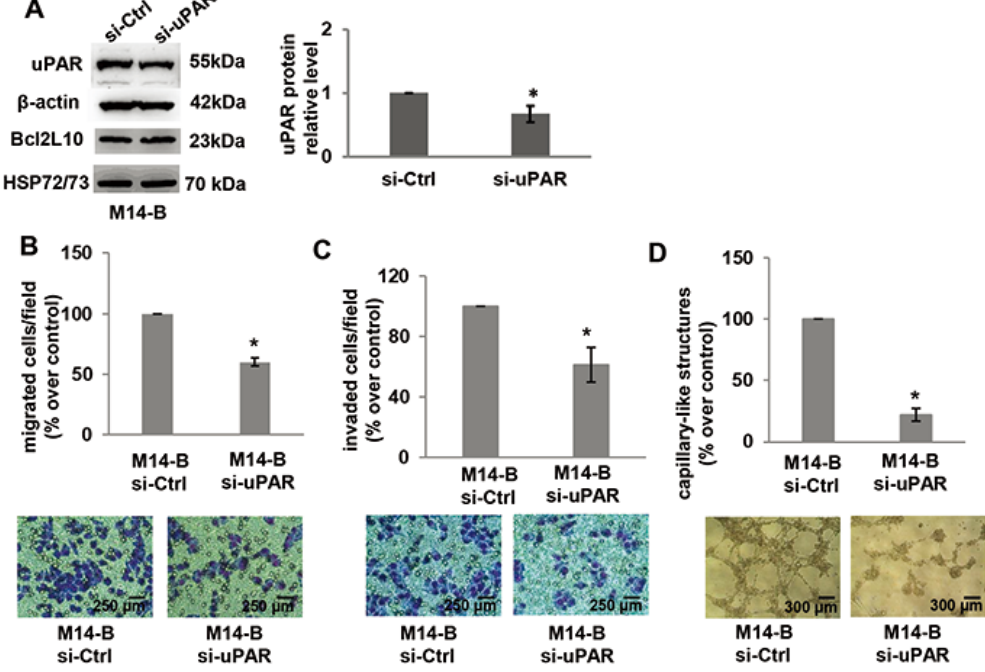
Figure 6. Bcl2L10 promotes migration, invasion, and VM of melanoma cells through uPAR. (A) Western blot analysis of uPAR and Bcl2L10 and densitometric analysis of uPAR protein expression in Bcl2L10 overexpressing M14 clone (M14-B) transfected with siRNA oligonucleotides against uPAR (si-uPAR) or scramble (si-Ctrl) target sequences. Reported images are representative of three independent experiments with similar results. β-actin and HSP72/73 were employed to check equal loading and transfer. For densitometric analysis, protein levels were quantified by using ImageJ software and the relative levels of proteins were expressed in the histograms as ratio changes respect to relative control after normalization. Data were expressed as mean ± standard deviation. Statistical analysis was performed applying corrected t test. (B–D) Quantification and representative images of in vitro cell (B) migration, (C) invasion, and (D) capillary-like structure formation in M14-B cells transfected with siRNA oligonucleotides against uPAR (si-uPAR) or scramble (si-Ctrl) target sequences. Values are expressed as a percentage of migrated/invaded cells or capillary-like structure formed respect to control. (B–D) Each condition was analyzed in duplicate in three (C) or two (B, D) independent experiments. Data were expressed as mean ± standard deviation. Scale bars have been reported. Statistical analysis was performed applying unpaired two-tailed student’s t test with Welch’s correction. * P <